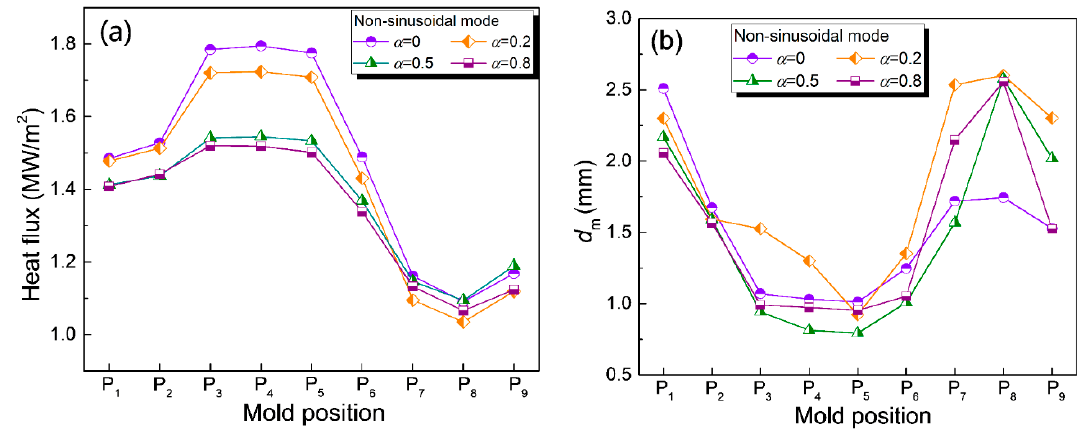
Figure 10. Variations of ( a ) transient heat flux at 3 mm below the meniscus. ( b ) d m during mold oscillation with different modification ratios.